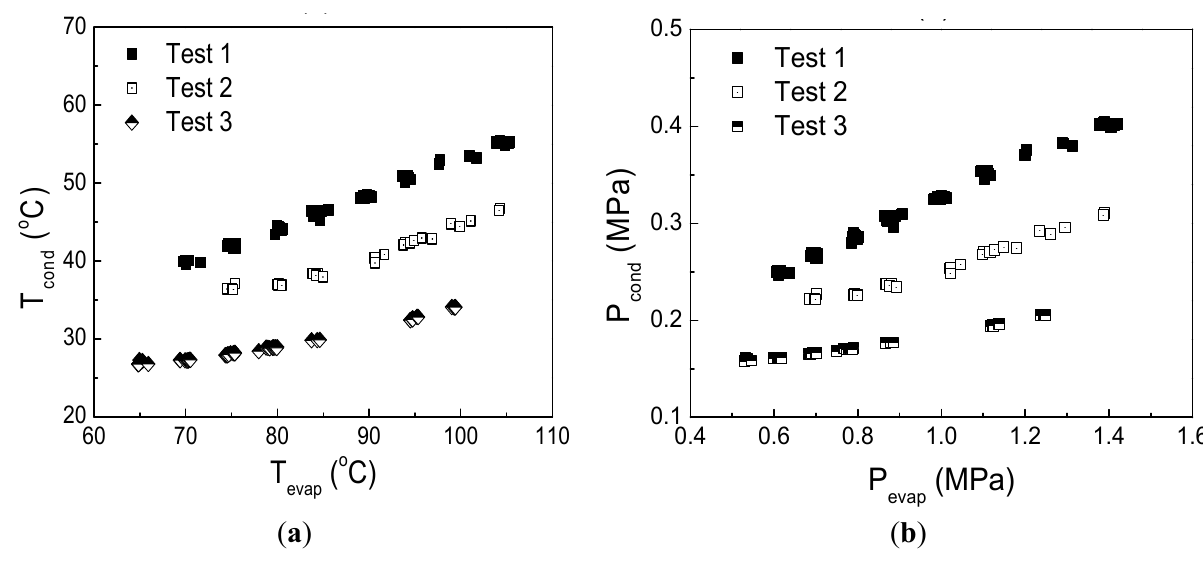
Figure 6. Variation in PI with changing VI for each